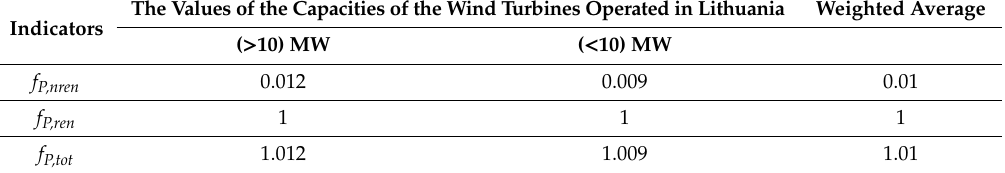
Table 4. The result of the PEF calculation.